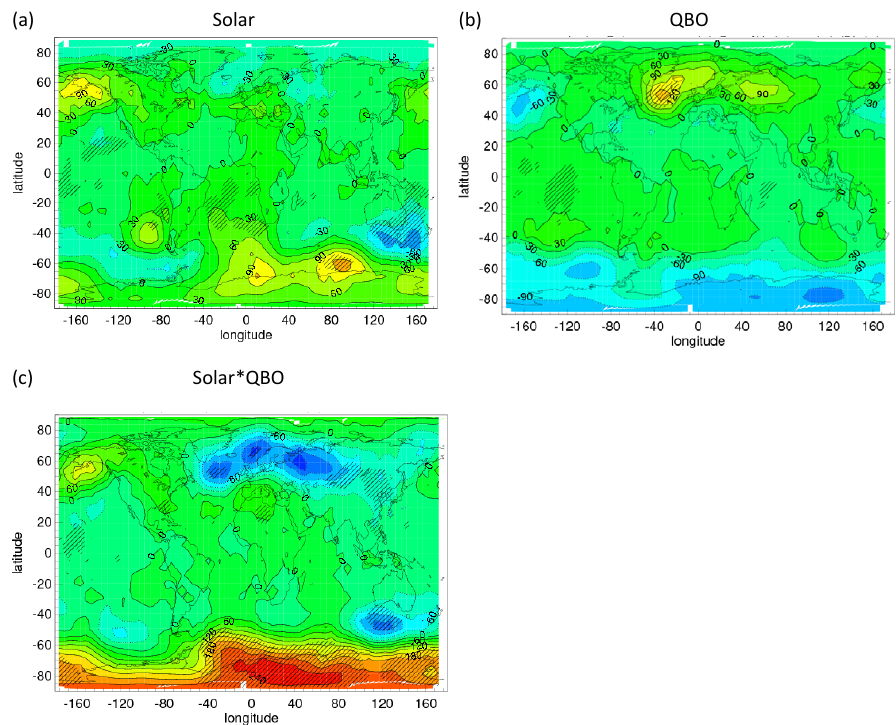
Fig. 4. Same as Fig. 3a, b and c respectively, but over the period 1900–2004, using the Brnnimann et al. (2007) QBO time series. The contour interval is 30Pa and colours around the zero contour are same as Fig. Figure 8 : as Figure 7 (a), (b) & (c) respectively, but over the period 1900-2004, using the Brönnimann et al. (2007) QBO time series. The contour interval is Figure 7.